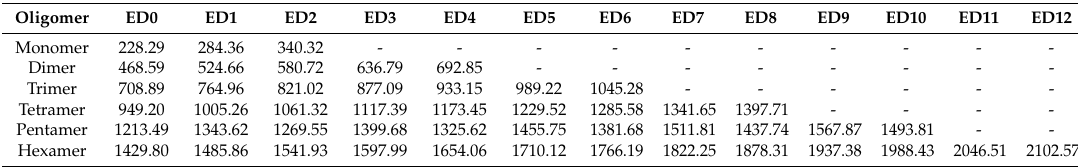
Table 1. Mass peaks as a function of the oligomer size versus epoxidation